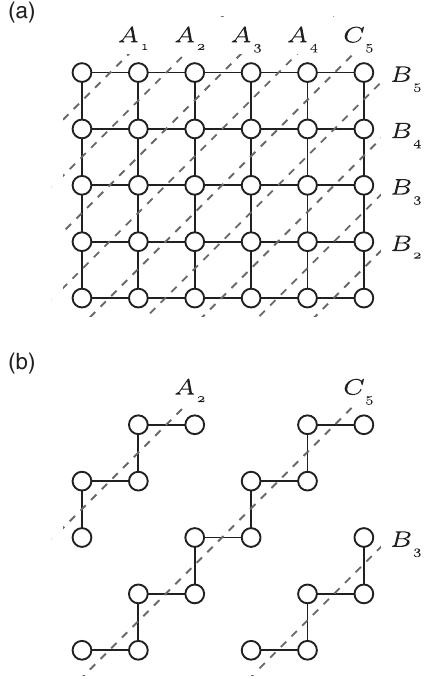
FIG. 2. (a) A cluster-state graph G imposed. The flow across each cut is independent, and the number of possible flows across each cut is indicated. (b) Several cuts with their neighboring vertices